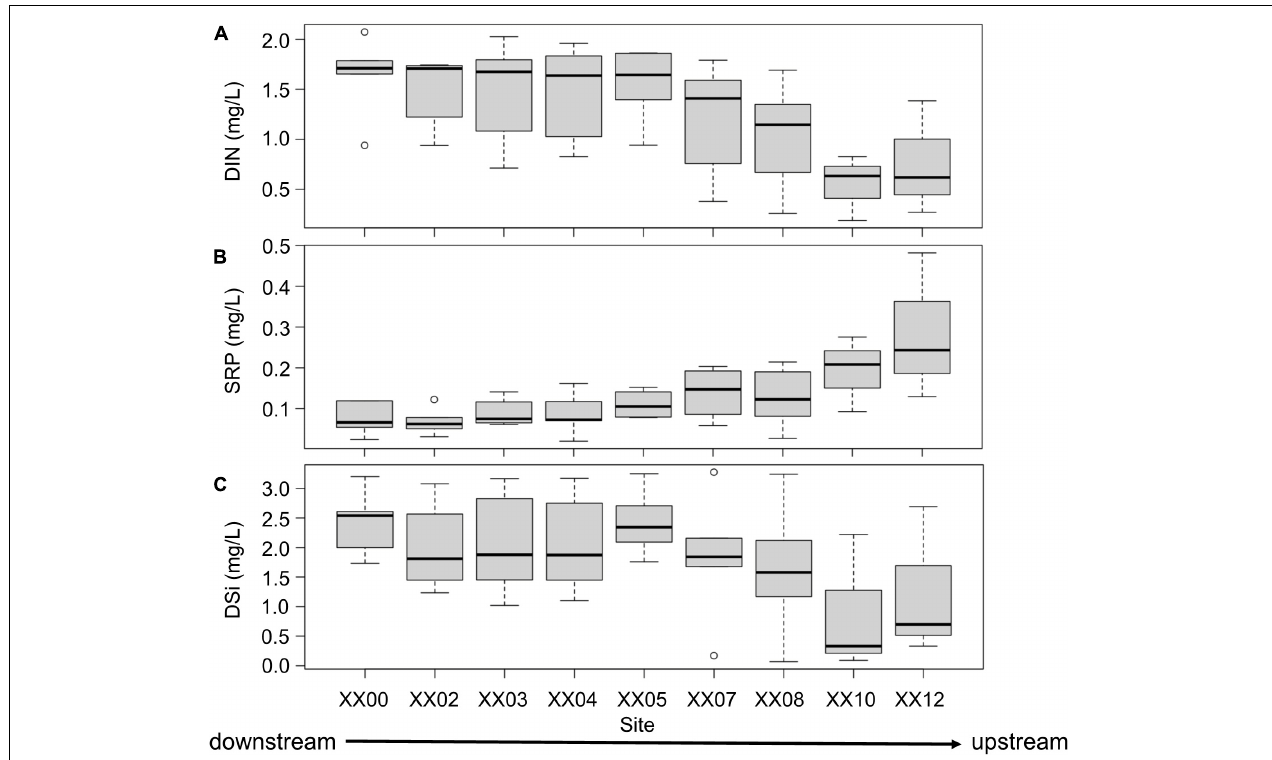
FIGURE 3 | Boxplots showing the spatiotemporal variation of DIN (A) , SRP (B) , and DSi (C) in the Xiangxi Bay of Three Gorges Reservoir. The sites were arranged by the distance to the mouth of the bay